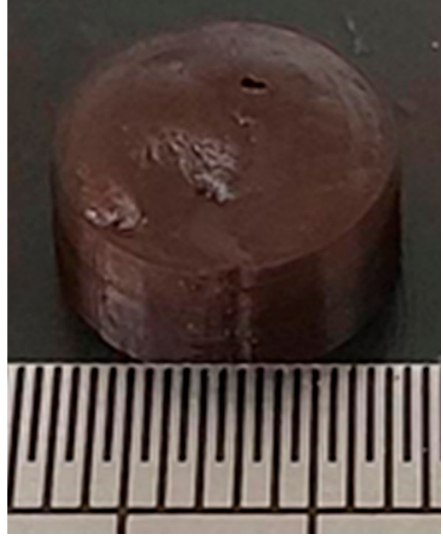
Figure 5. ‘Control’ pellet containing drug and formulation combinations used in multicompartment PLHs. Composed of 82.5% 1:1 SMEDDS + Gelucire ® 48/16, with 7% clofazimine, 7% lumefantrine and 3.5% halofantrine. (Scale is 1 mm per fine graduation).